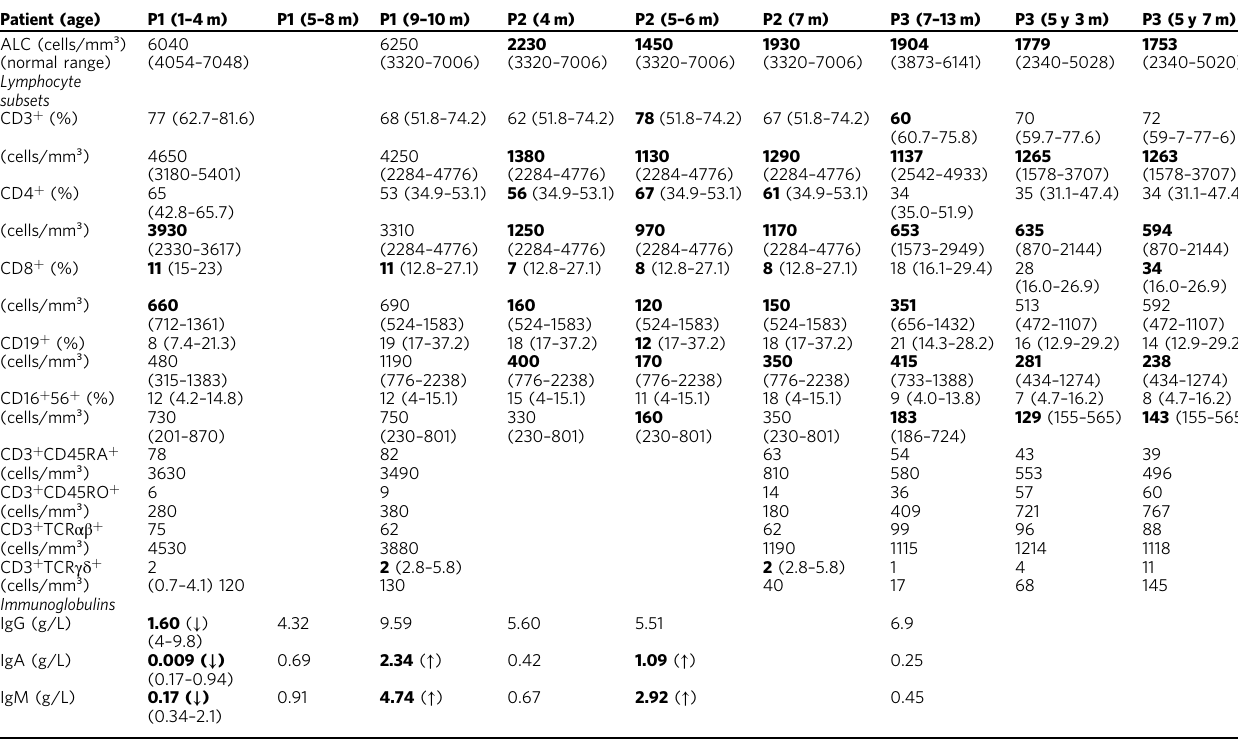
Table 1 Immunological data on patients with DEF6 mutations Patient